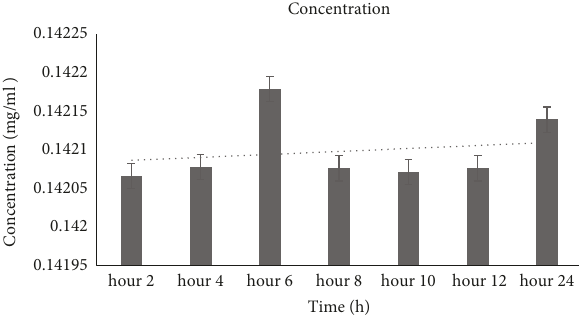
Figure 5: In vitro drug release study during 24h at 37 ° C, at 415nm. The absorbance was 0.1420